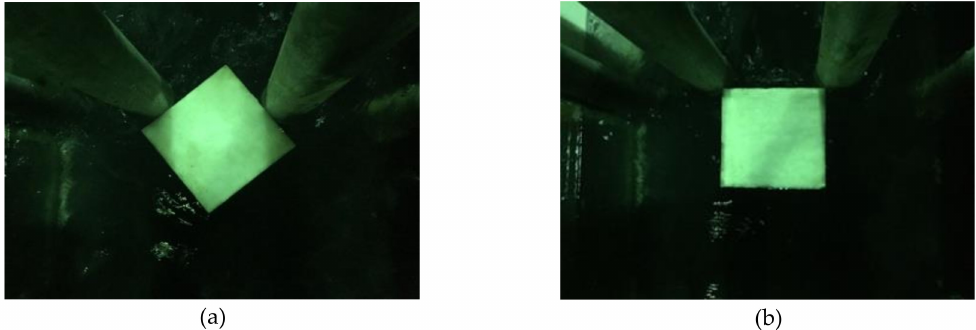
Figure 2. Illustration of the ice block making contact with the pier columns: ( a ) ice block in contact with the pier columns at 45 ◦ ; ( b ) ice block in contact with the pier columns at 90 ◦